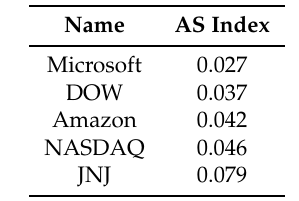
Table 11. The AS Performance Index for One-period Gambles in Ascending Order for the Stock Returns. Table 11 presents the AS performance index for one-period gambles assuming the underlying stochastic process to be a normal mixture process with time-invariant volatility.